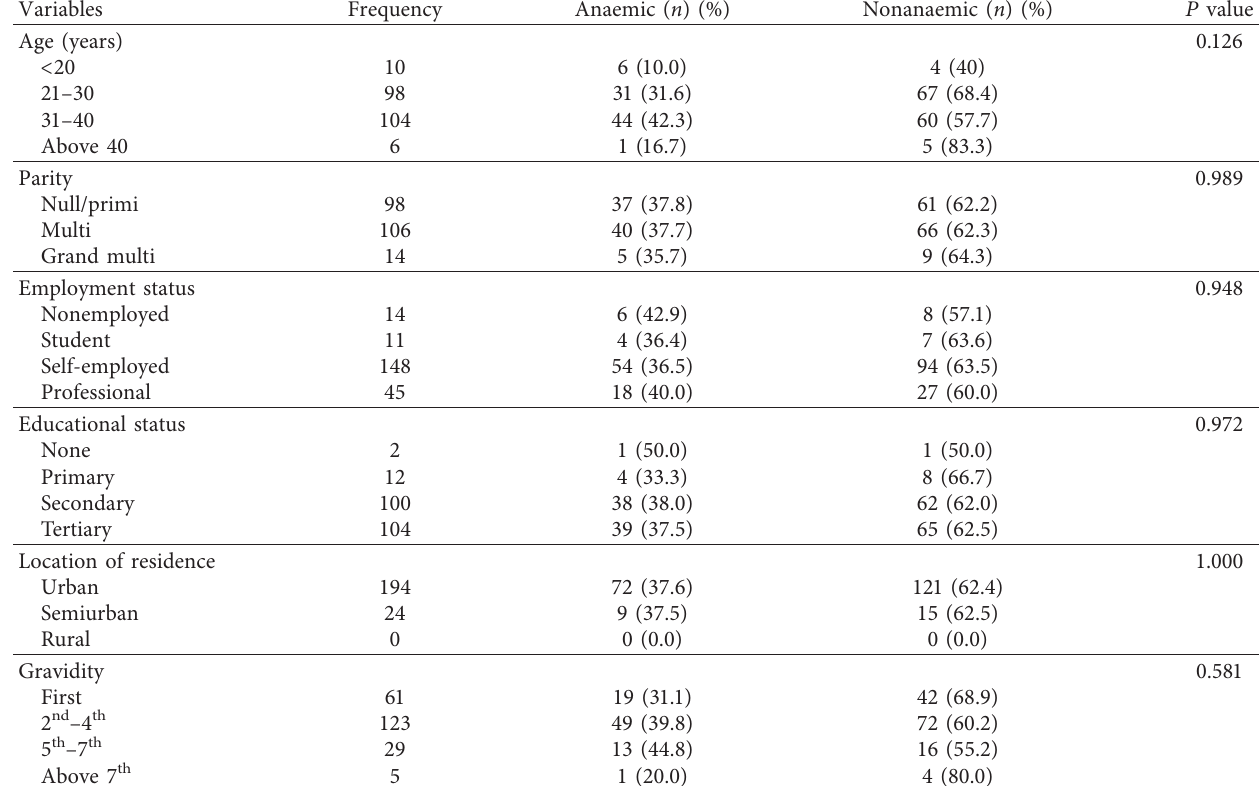
Table 4: Distribution of anaemia in pregnancy among the study